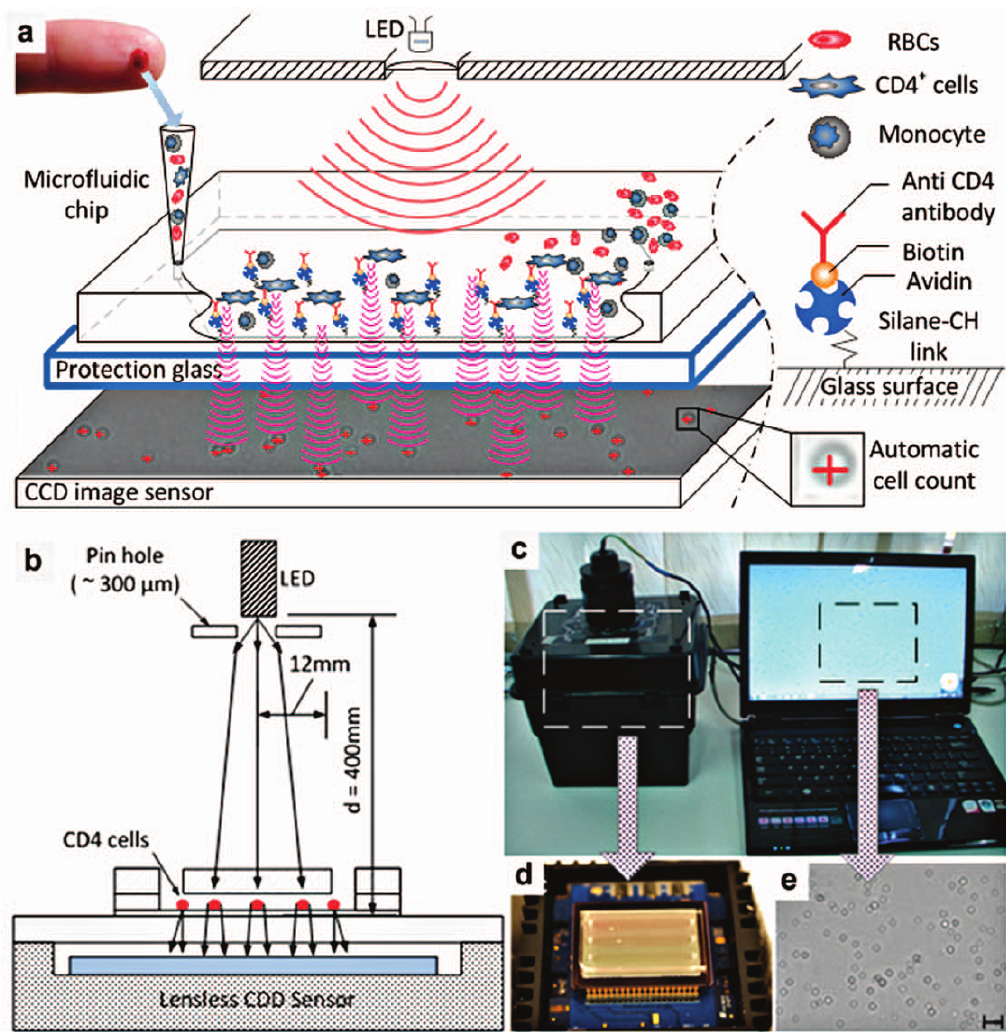
Figure 1. Depiction of the working principle of CD4 + T-lymphocyte counting microchip platform for the POC. ( a ) Shadow images of captured cells were obtained using a large area CCD image sensor (24 6 34 mm, 10 mega pixel). A pinhole LED (Light Emitting Diode) was used as a light source. The POC platform has following two main processes. First, a microfluidic chip captured target CD4 + cells from unprocessed fingerprick volume of HIV-infected whole blood by anti-CD4 antibody which was immobilized on the microchip surface. Second, the captured cells were imaged using the wide field of view (FOV) lensless CCD platform within a second. White light generated from LED light source went through a 100 m m pinhole and illuminated captured cells. Cell shadows were automatically detected and rapidly counted by automated image recognition software on a portable laptop computer. ( b ) Schematic representation and drawing of the lensless imaging system for microfluidic CD4 count, ( c ) Photograph of entire POCT CD4 imaging system, (d) microfluidic CD4 chip on top of CCD sensor inside a black box, (e) lensless imaging and magnified image represents the diffracted shadow signal of the cell shape. Scale bar is 200 m m. Entire platform setup and operational details were shown in Text S1 .